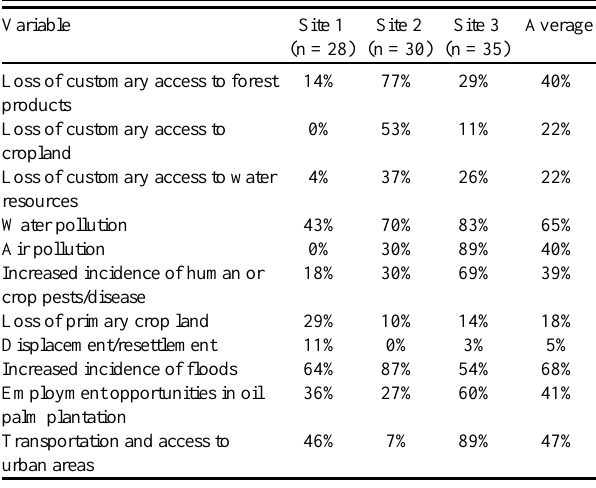
Table 13 . Perceived social and economic effects associated with the oil palm